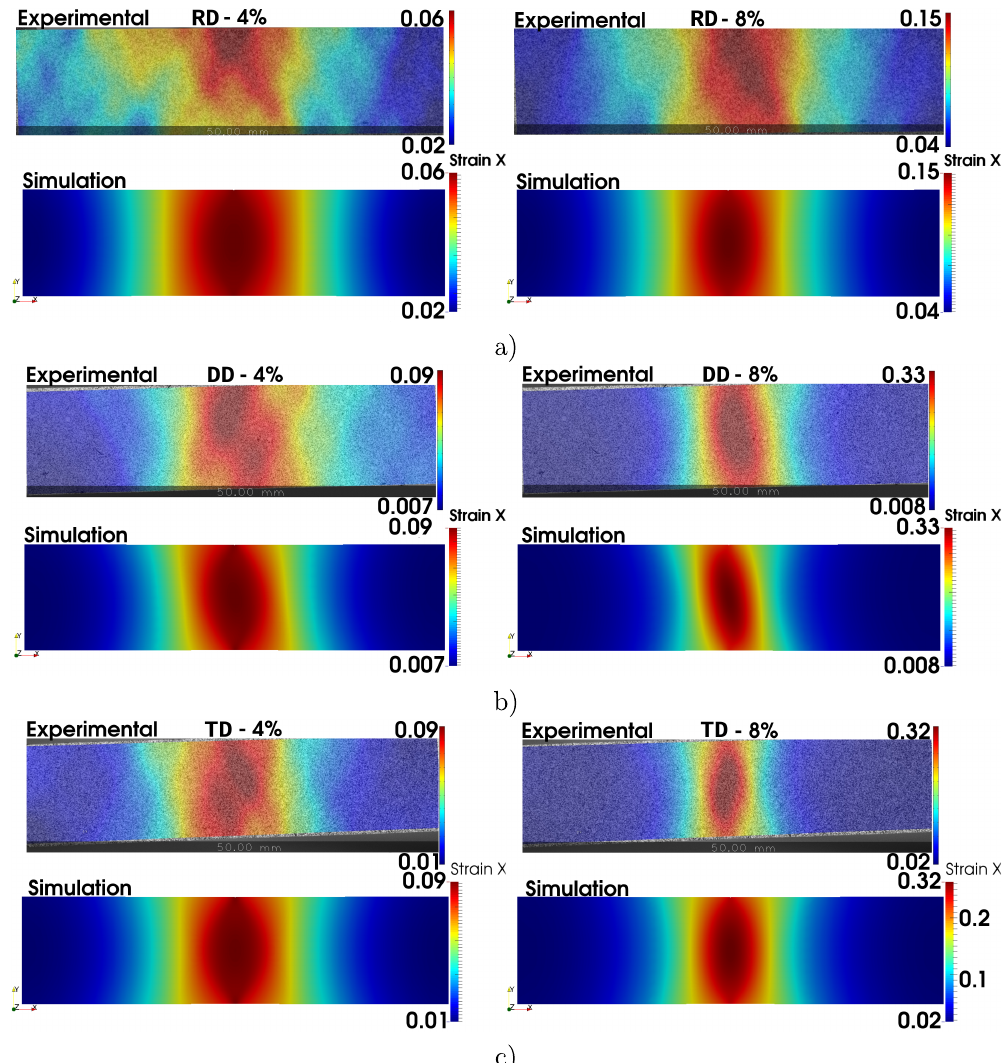
Figure 10. Comparison of DIC measurements and computed ε l contours for 4% and 8% of ε eng for the ( a ) RD, ( b ) DD, and ( c ) TD tensile